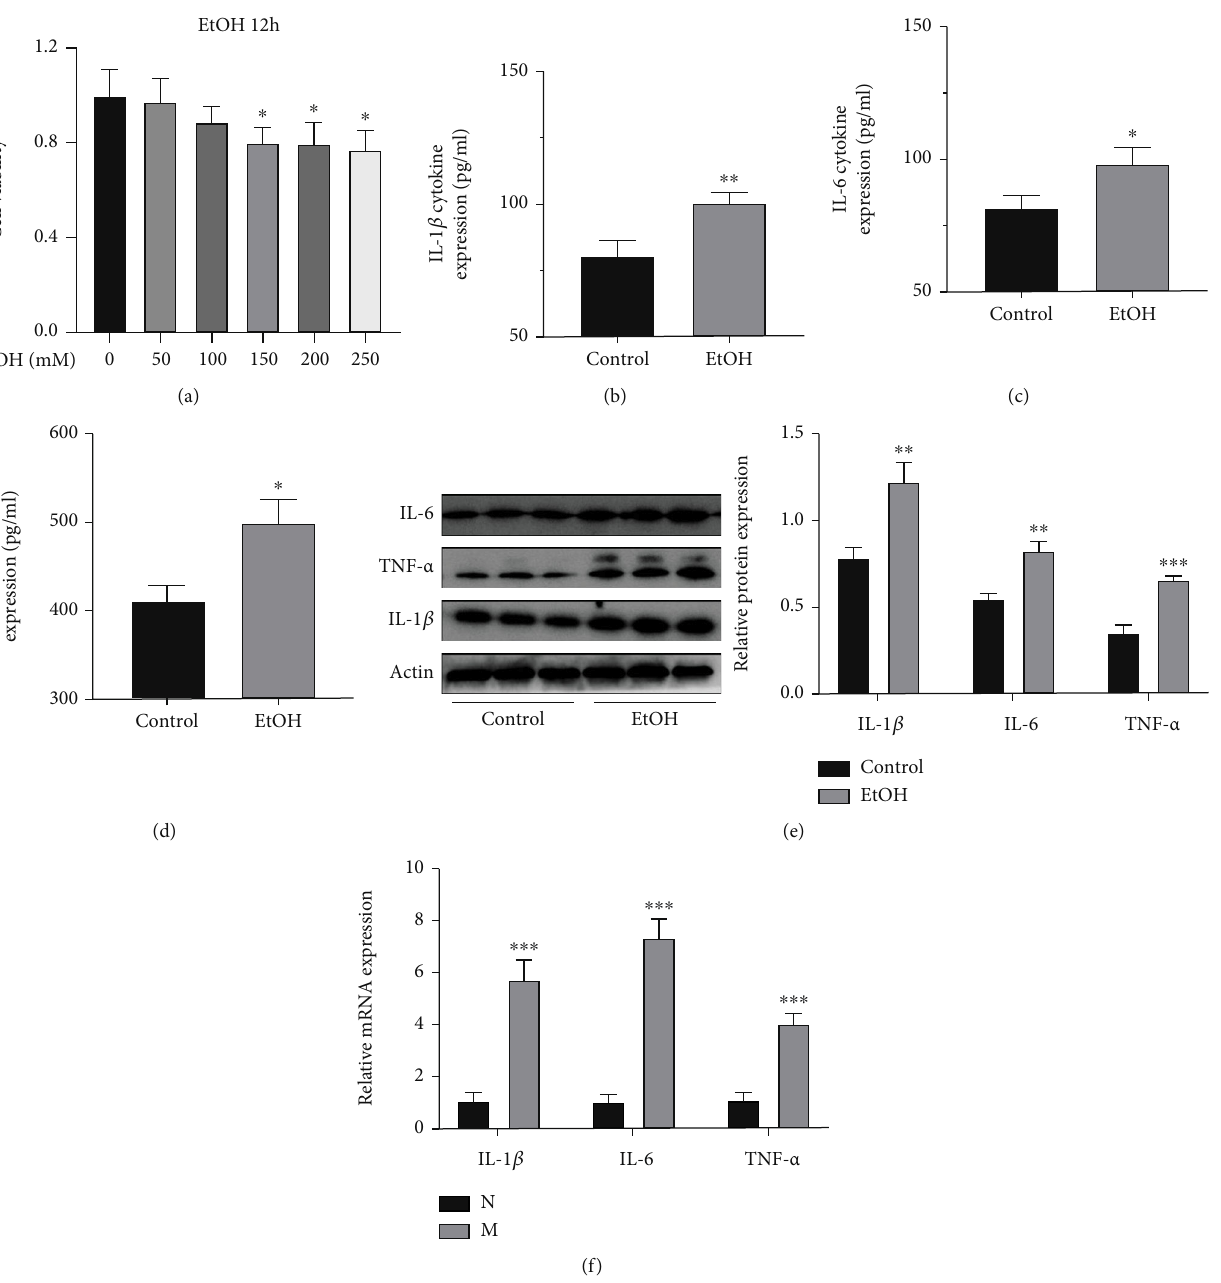
Figure 6: The establishment of cell model. (a) Relative cell viability of RAW264.7 cells. (b – d) Levels of IL-1 β , IL-6, and TNF- α in the supernatant of RAW 264.7 cells. (e) Relative protein expression of IL-1 β , IL-6, and TNF- α . (f) Relative mRNA expression of IL-1 β , IL-6, and TNF- α in the RAW264.7 cells. ∗ P < 0 : 05, ∗∗ P < 0 : 01, and ∗∗∗ P < 0 : 001 compared with the Pair-fed group. # P < 0 : 05, ## P < 0 : 01, and ### P < 0 : 001 compared with the EtOH-fed group. The data represent the mean ± S : D : of at least three independent